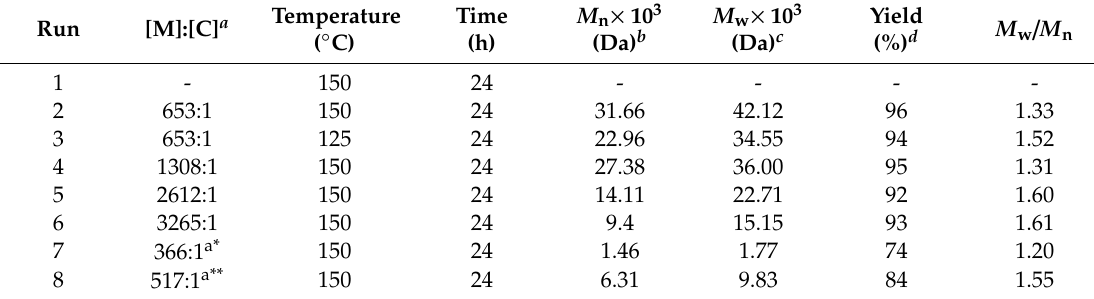
Table 3. ROP of ε -CL catalyzed by 18 [41].